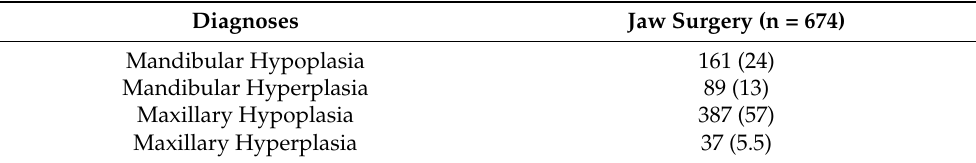
Table 2. Preoperative diagnoses according to ICD-9-CM and ICD-10-CM. Reported as n